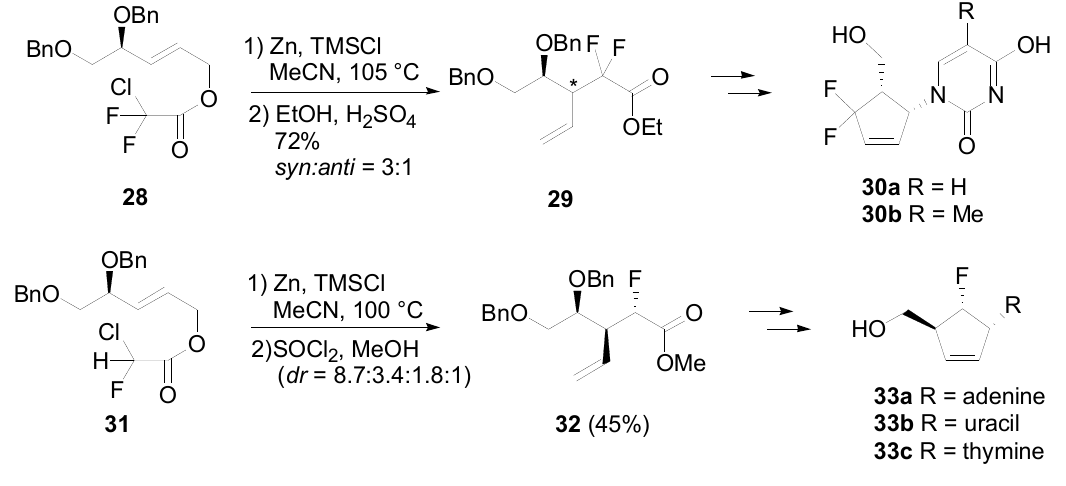
Scheme 8. Synthesis of carbocyclic nucleosides by